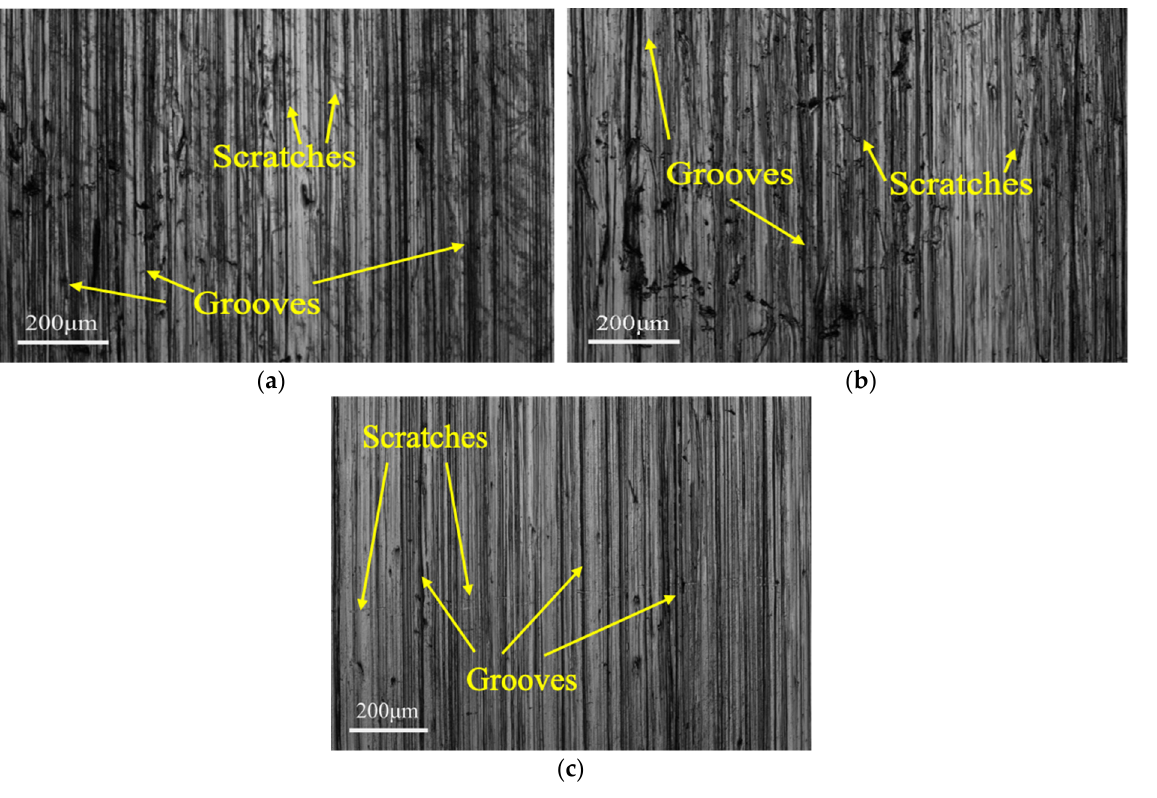
Figure 7. SEM images in the middle area on the sample surfaces after the wear test with slurries containing 20 wt.% of a mixed abrasive: ( a ) talc and quartz, ( b ) dolomite and quartz, and ( c ) fluorite and quartz.